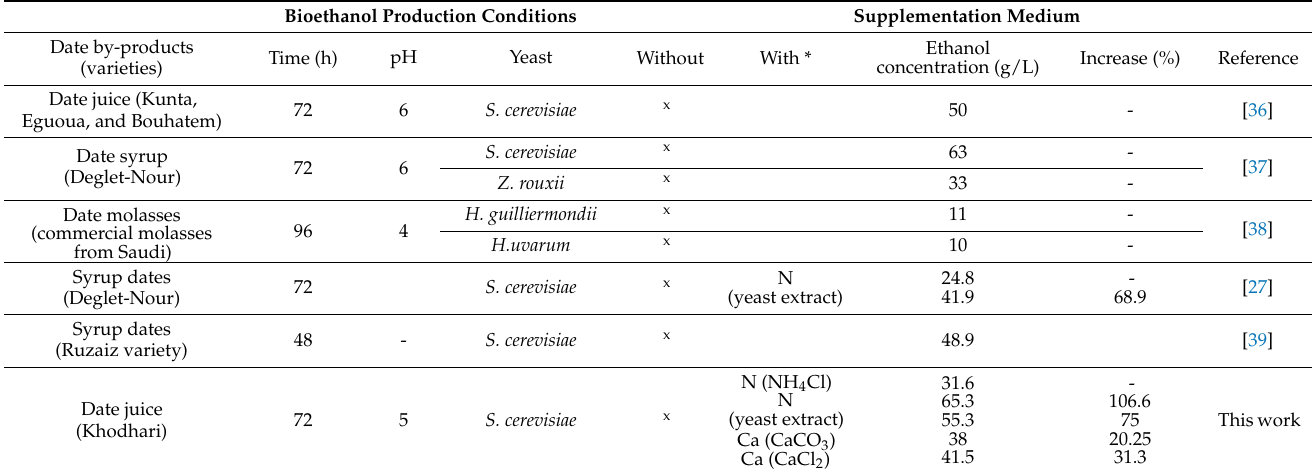
Table 2. Comparison of production conditions and performance of our produced bioethanol with other varieties in the literature.